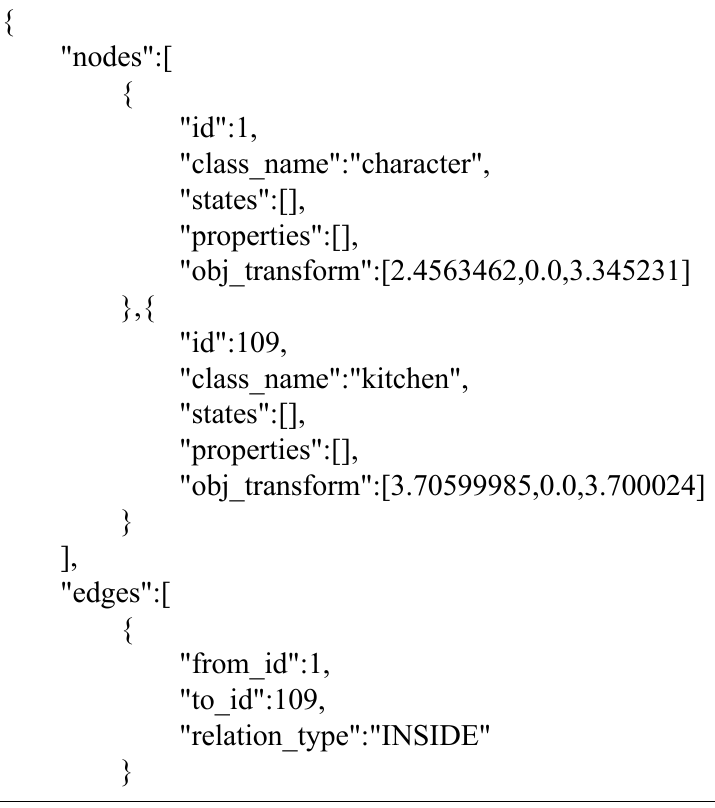
Figure 8. Part of the environmental graph.